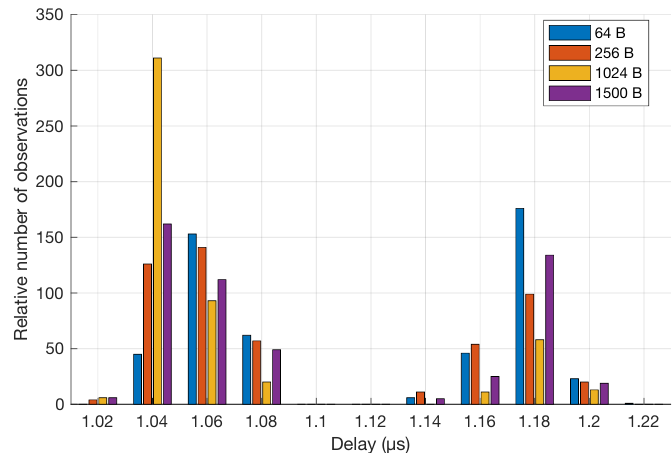
Figure 10. Delay to enter a UDP callback function after receiving packet using Ethernet Direct Copy